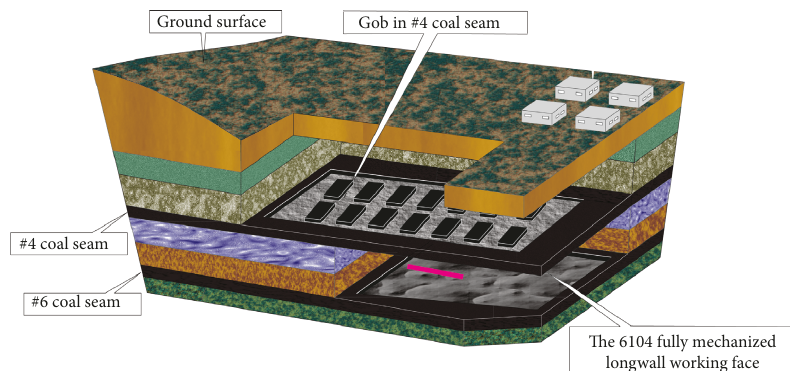
Figure 1: Schematic diagram of mining status in the Yuanbaowan coal mine.